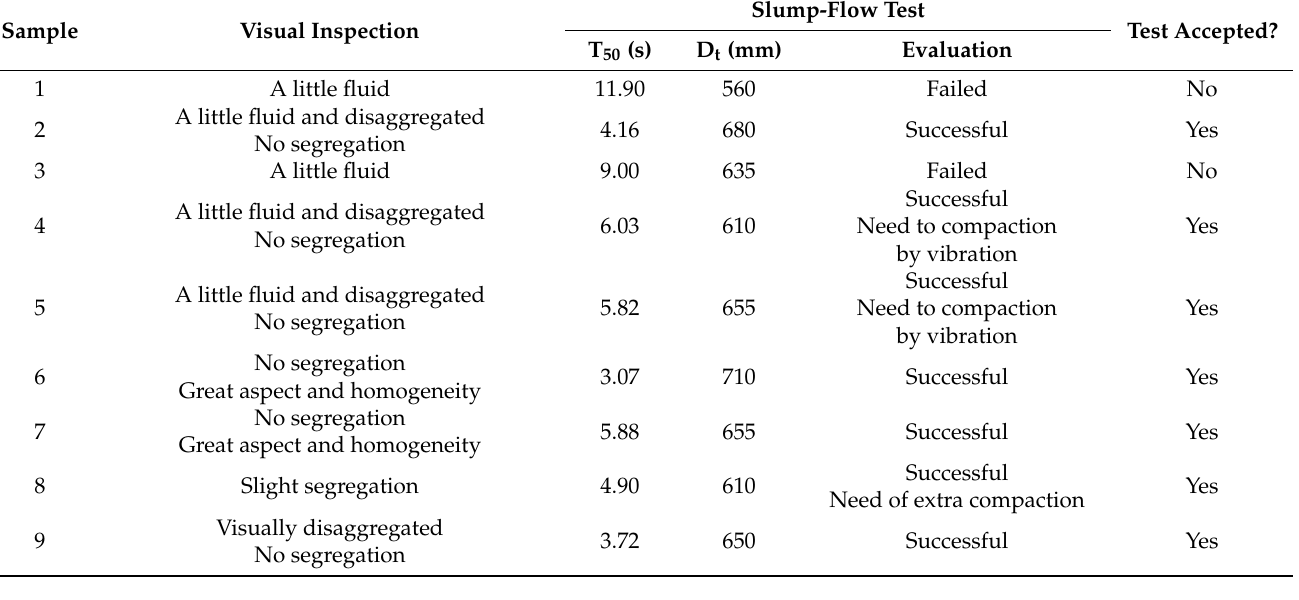
Table 15. Visual inspection and slum test results of the pilot plant scale high-strength self-compacting concrete production. Sample